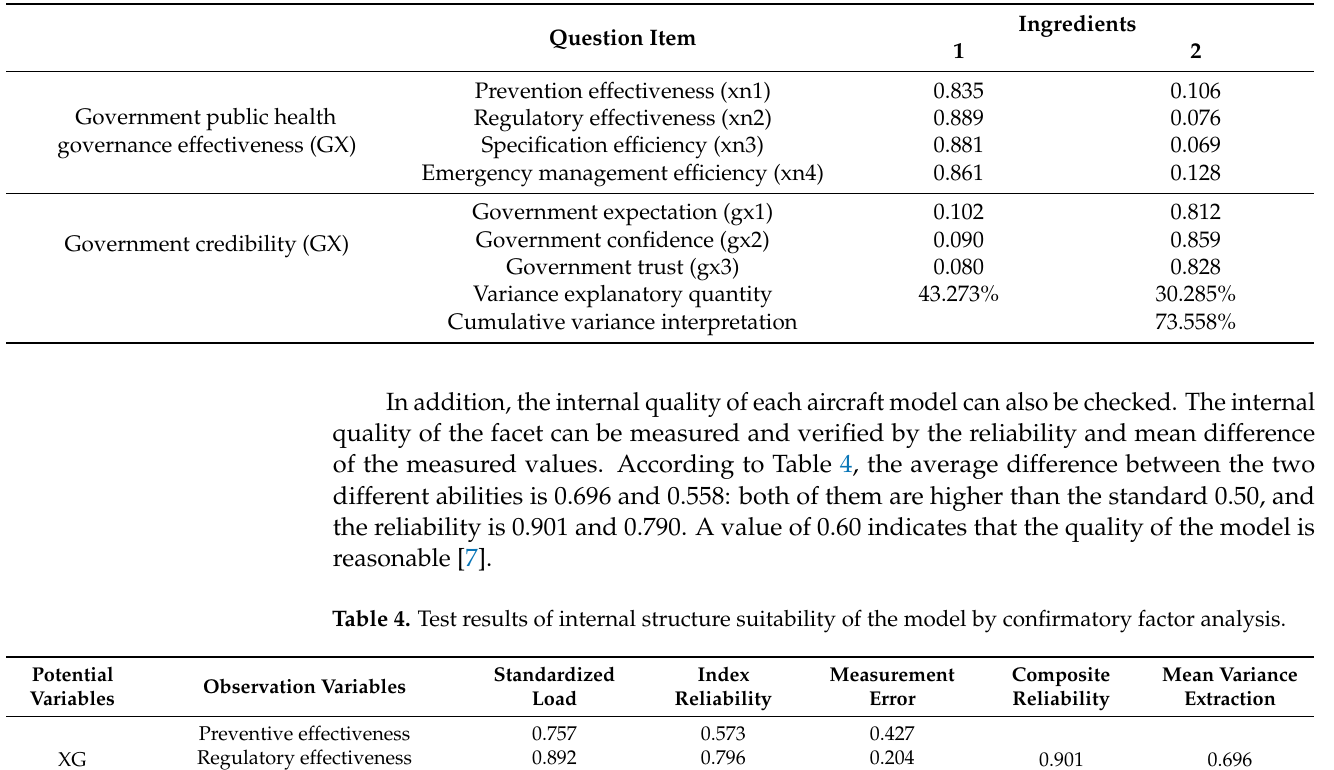
Table 3. Total variation and rotated component matrix of factor interpretation extracted from the scale.